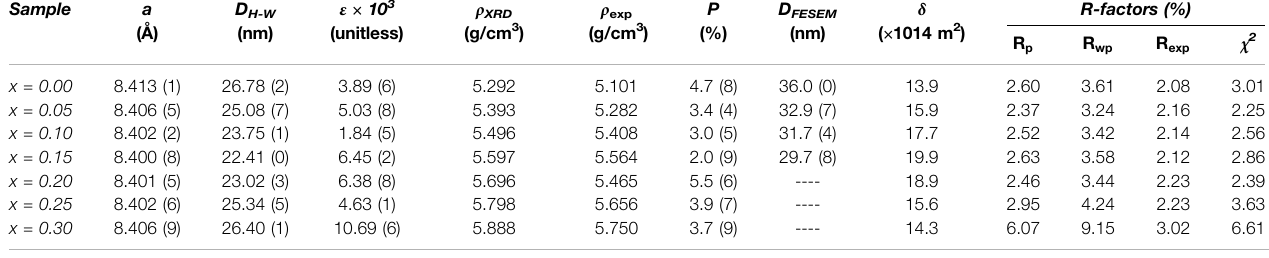
TABLE 2 | The a , D H-W , and ε , dislocation density ( δ ), theoretical and experimental density, porosity percentage, mean particle size ( D FESEM ), and as well as R-factors values related to the quality of Rietveld re fi nement. Sample